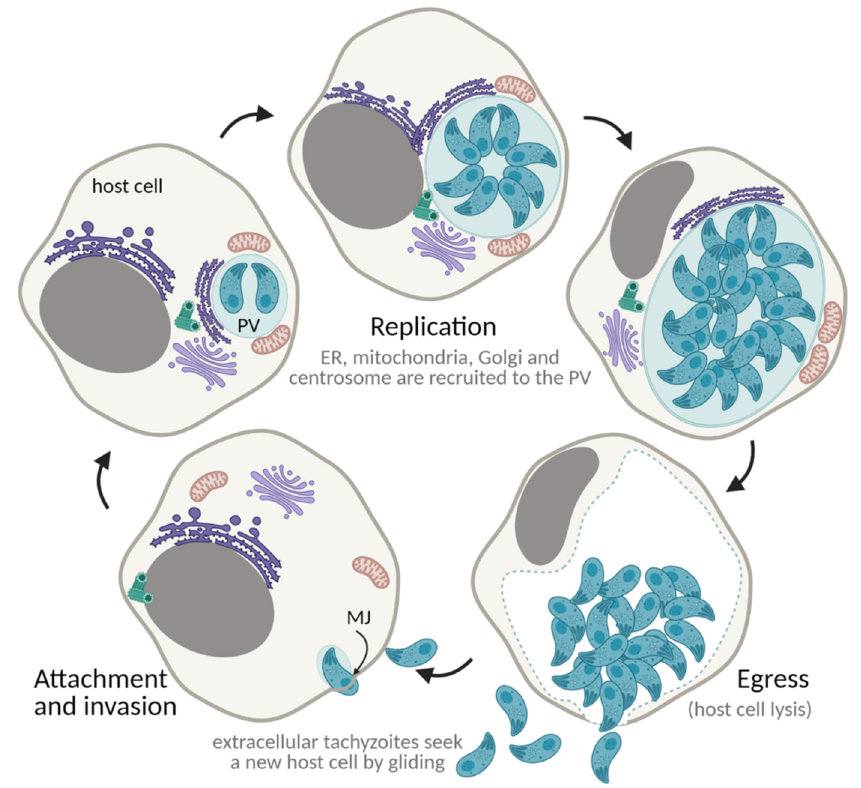
Figure 6. The lytic cycle. ER—endoplasmic reticulum; PV—parasitophorous vacuole; MJ—moving junction. Created with BioRender.com (accessed on 5th December 2021).